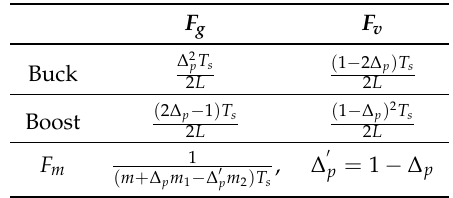
Table 2. Current programmed controller gains.